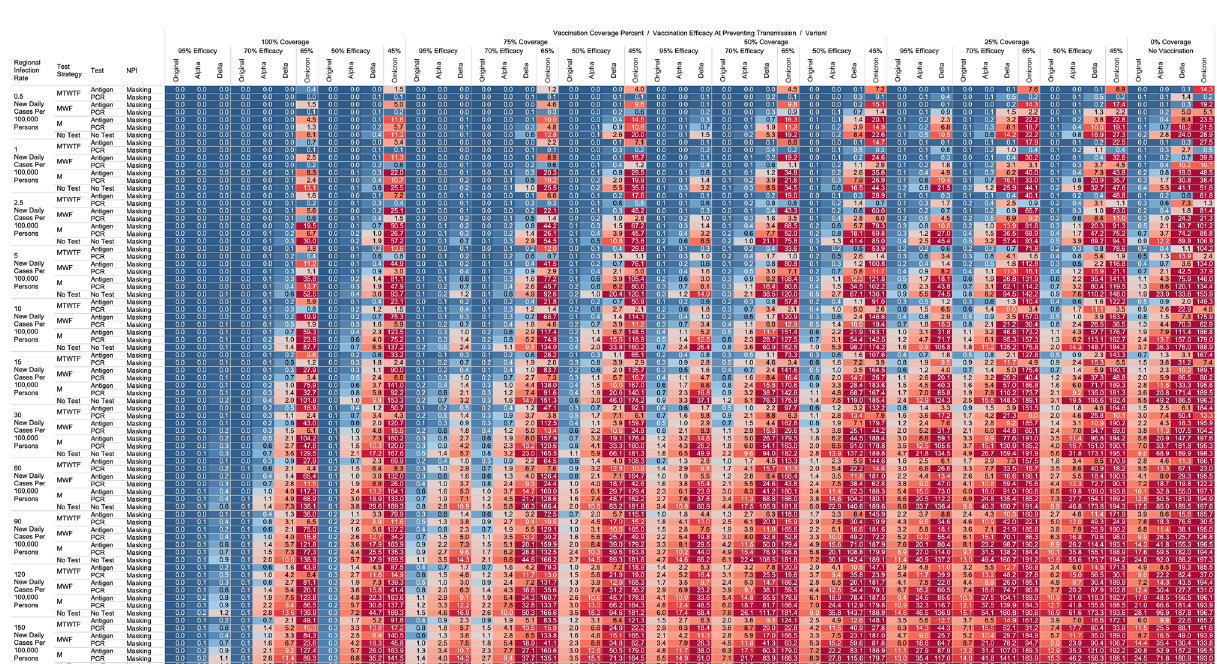
Figure 5. Heatmap of simulated workplace-acquired infections through 4800 person weeks with testing performed in all workplace members with consistent mask wearing. The sensitivities of PCR and antigen tests a variant specific as outlined in Table